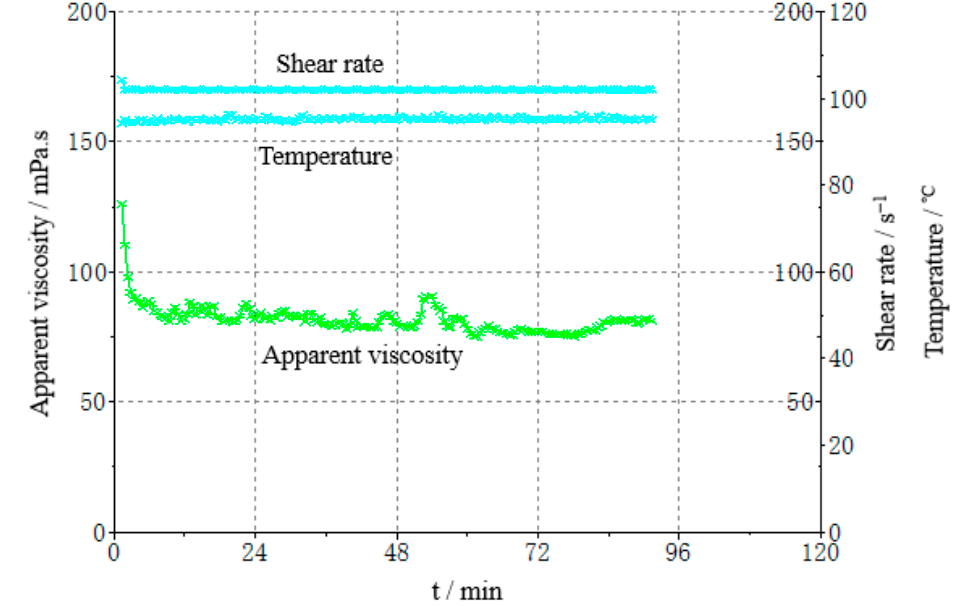
Figure 20. Evaluation of rheological properties of gel fracturing fluid with